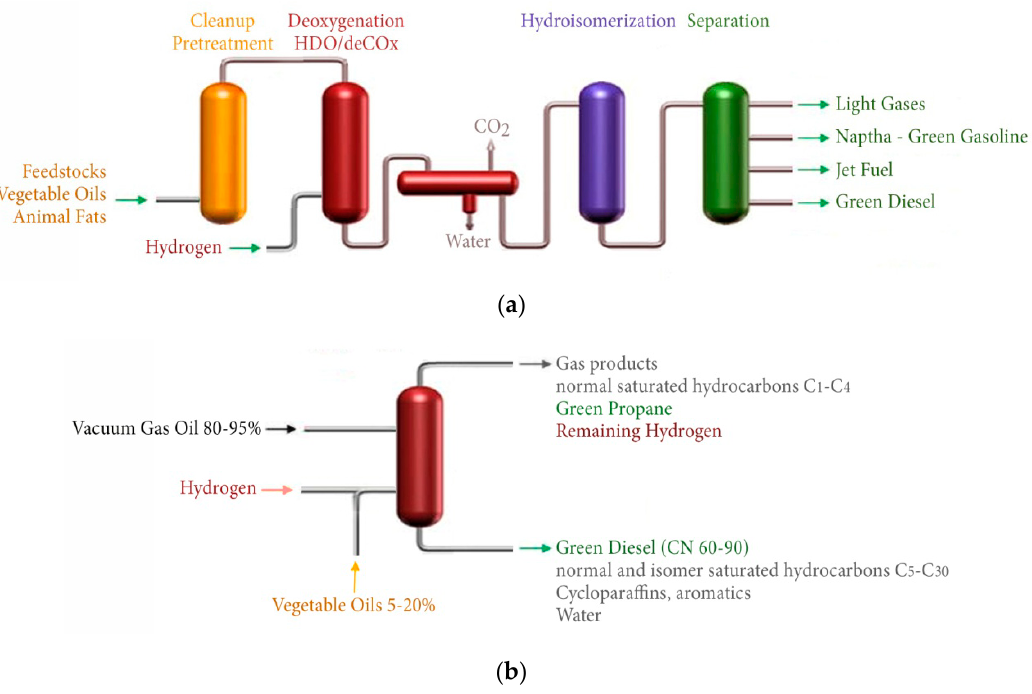
Figure 3. Schematic representation of a standalone biomass hydroprocessing plant ( a ) and a co-prosessing hydroprocessing plant for biomass and petroleum distillates ( b ).